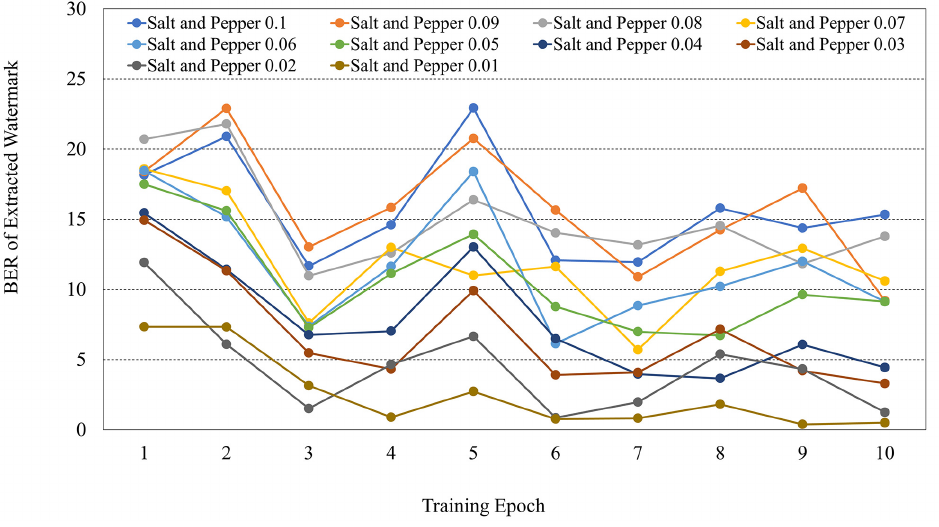
Figure 9. Re-training result for the salt and pepper noise.